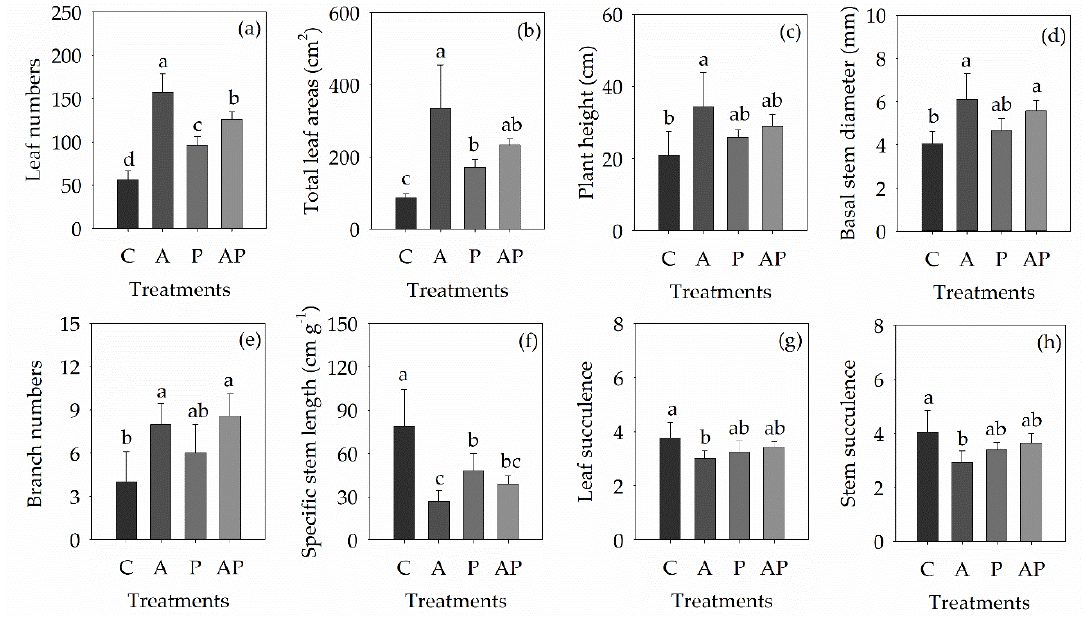
Figure 4. E ff ects of Glomus mosseae and Bacillus amyloliquefaciens on aboveground organ morphological characteristics of Elaeagnus angustifolia L. seedlings in saline soils. Values are the means ± standard deviation of five replicates. Value sharing the di ff erent letters indicate significant di ff erences between treatments at the 5% level (Tukey’s t -test). C: Control, A: AMF ( Glomus mosseae ) treatment, P: PGPR ( Bacillus amyloliquefaciens ) treatment, AP: AMF + PGPR treatment. ( a ) Leaf numbers, ( b ) total leaf areas, ( c ) plant height, ( d ) basal stem diameter, ( e ) branch numbers, ( f ) specific stem length, ( g ) leaf succulence, ( h ) stem succulence.